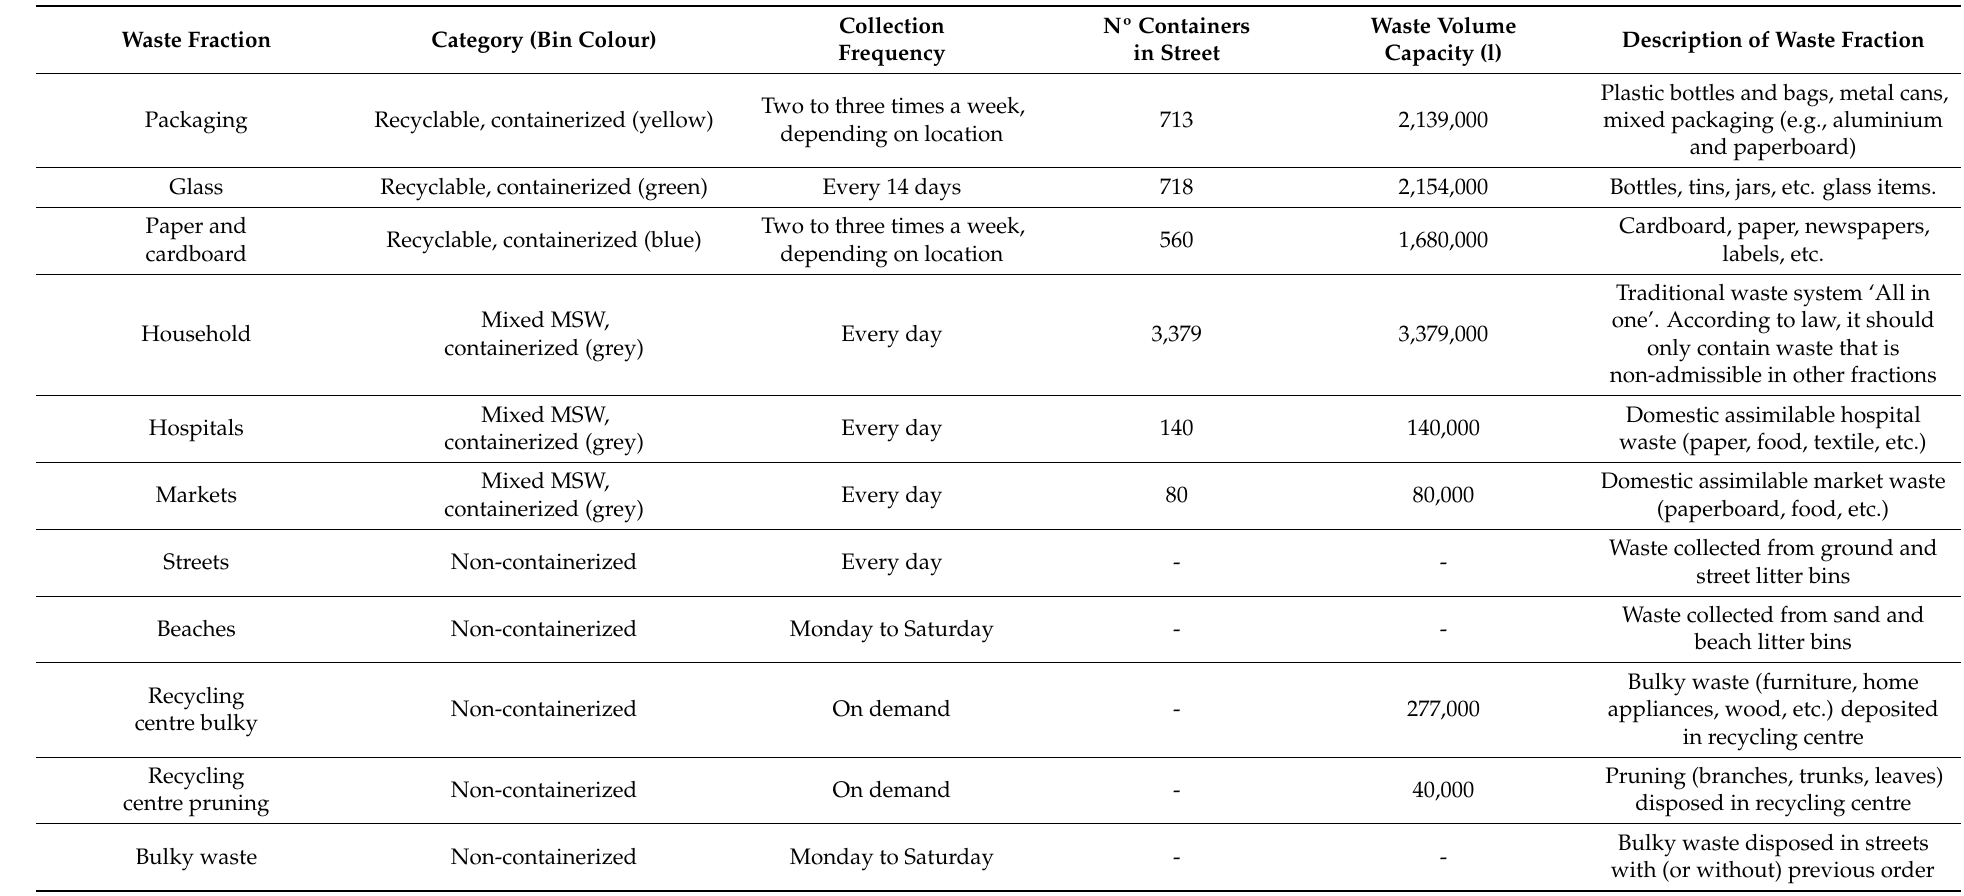
Table 2. Waste fraction characteristics of Castell ó